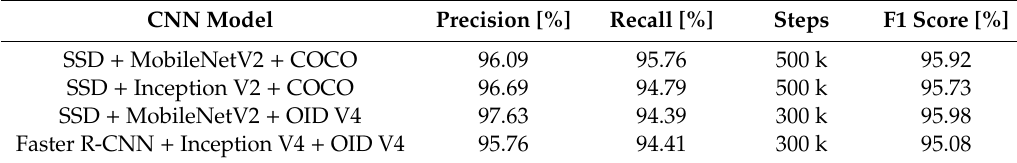
Table 3. Evaluation of fine-tuning object detectors on Pascal VOC metrics.